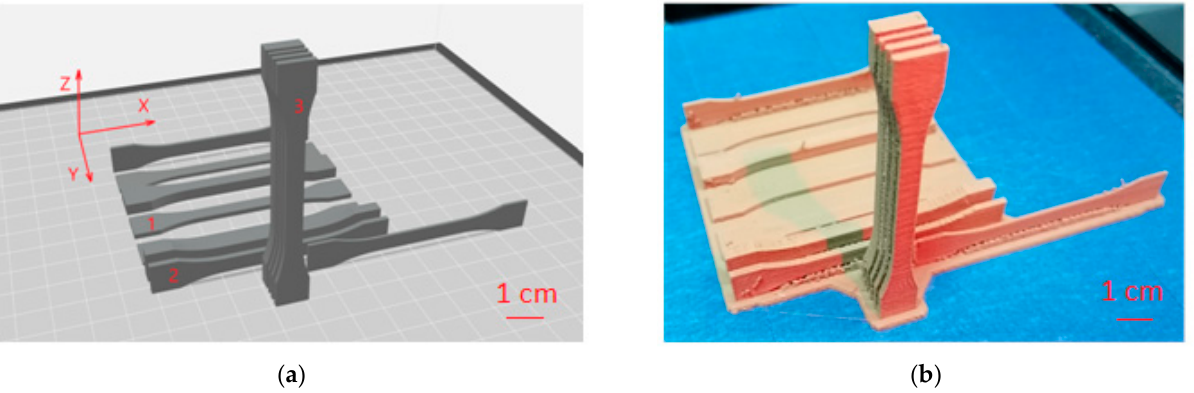
Figure 1. Specimens on the virtual build platform of the fifth-generation MakerBot Replicator. ( a ) Arrangement of models in the MakerBot software printed along: 1—the X axis; 2—the Y axis; and 3—the Z axis; ( b ) a series of 3D-printed specimens.